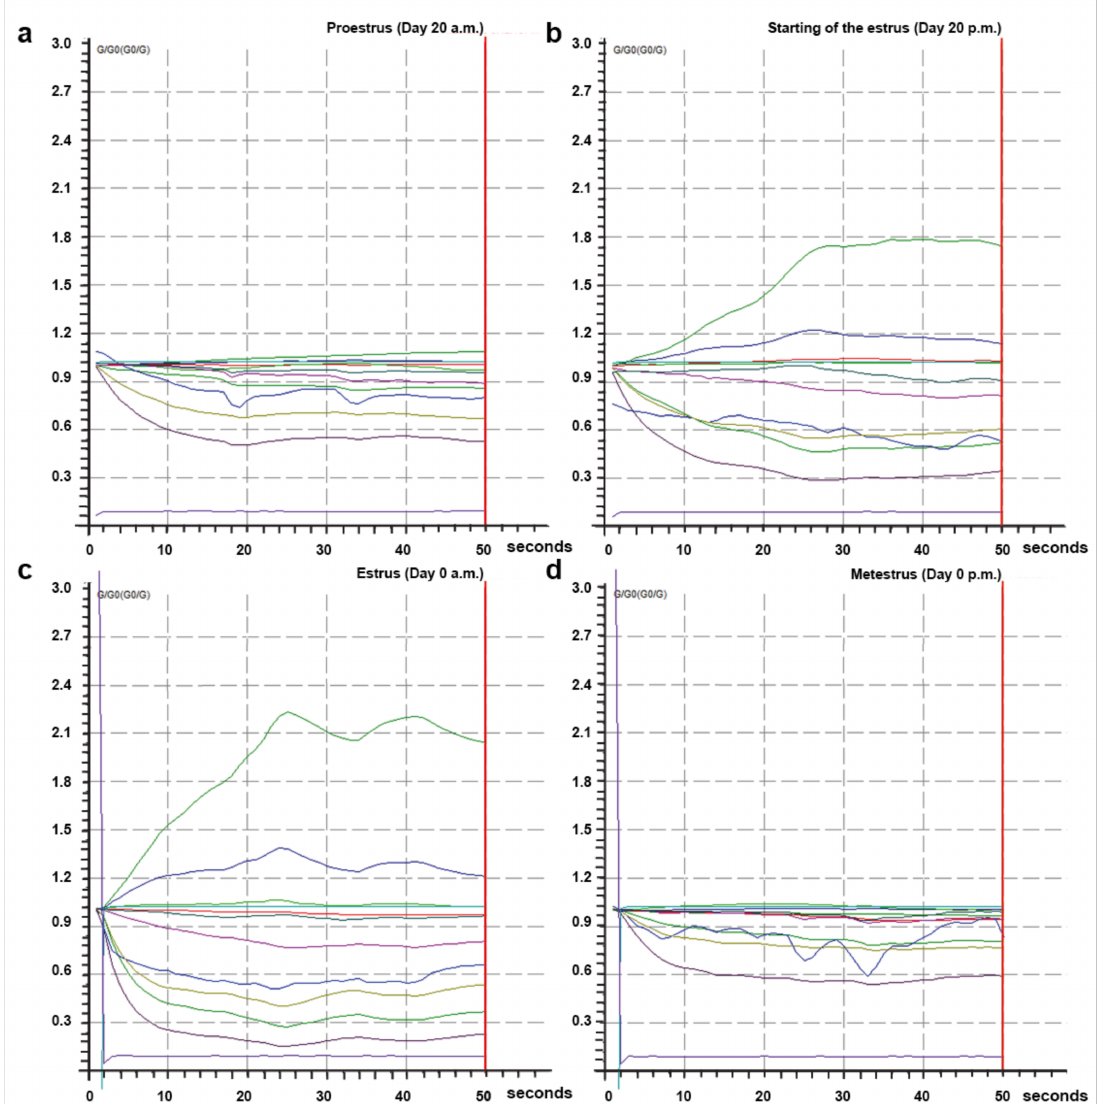
Figure 4. Response from the 10 metal-oxide sensors at different phases of the reproductive cy- cle to perineal odor in a cow from group II. ( a ) Response from the 10 metal-oxide sensors at proestrus (day 20, a.m.). ( b ) Response from the 10 metal-oxide sensors at the beginning of the estrus (day 20, p.m.). ( c ) Response from the 10 metal-oxide sensors at estrus (day 0, a.m.). ( d ) Response from the 10 metal-oxide sensors at metestrus (day 0, p.m.). The x-axis represents detection time, and the y-axis represented the changes of G/G0 values of EN sensors. Each colored line represents one